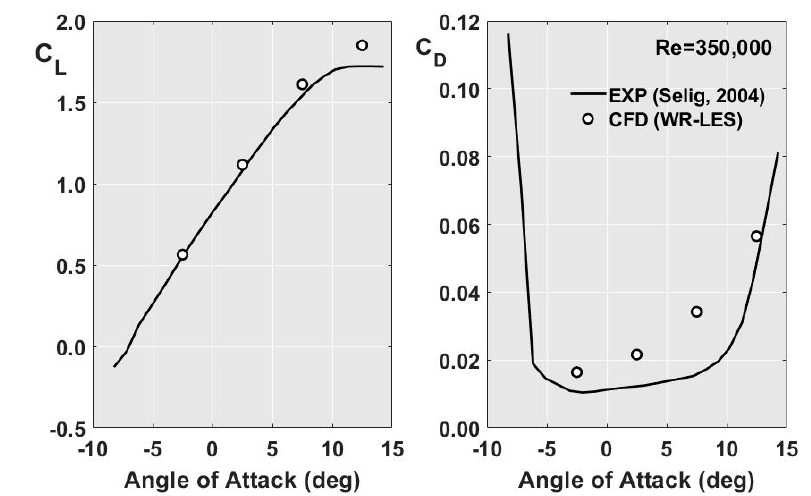
Figure 6. Comparison of experimental (the data from Selig and McGranaham [13]) and numerical aerodynamic coefficients at Re = 350,000.